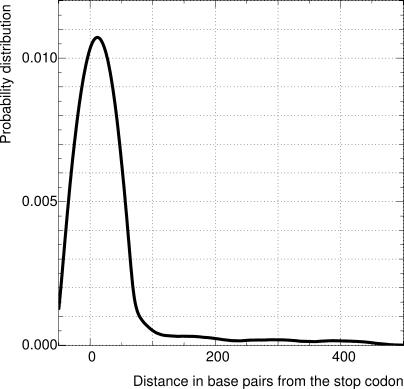
Distribution of the Position of B. subtilis Rho-Independent Terminators with Respect to the Stop Codon of the Last Gene in the OperonThe distance between the first nucleotide of the stem-loop and the last nucleotide of the stop codon is shown.